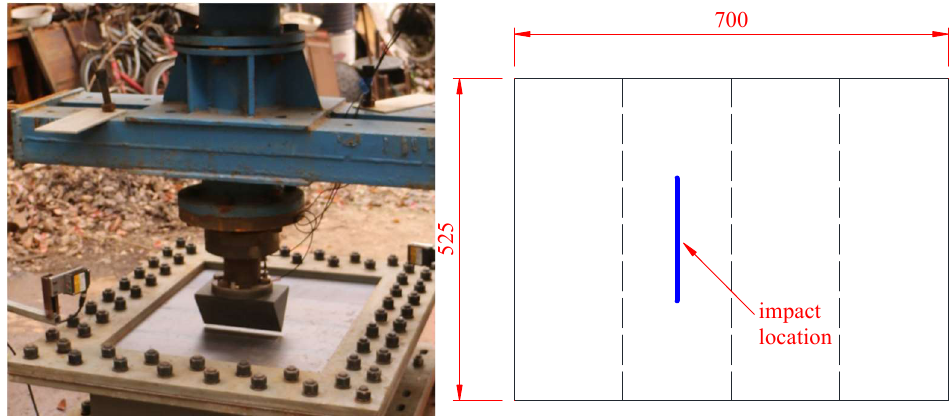
Figure 9. Eccentric impact scenario: impact on the plate between two stiffeners.